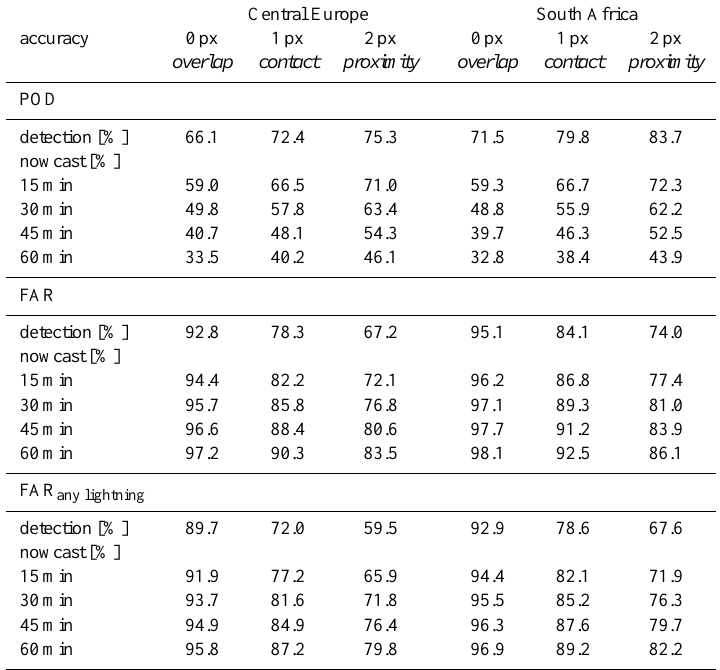
Table A1. Night: pixel-based validation scores for the current Cb-TRAM night-time detection scheme for mature storms, and the 15, 30, 45 and 60min forecasts. Top – POD for intense lightning pixels ( > flashespixel − 1 15min − 1 ); centre – FAR with regard to intense lightning pixels ; bottom – FAR any lightning with regard to pixels containing any lightning ( > 0flashespixel − 1 15min − 1 ). Central Europe